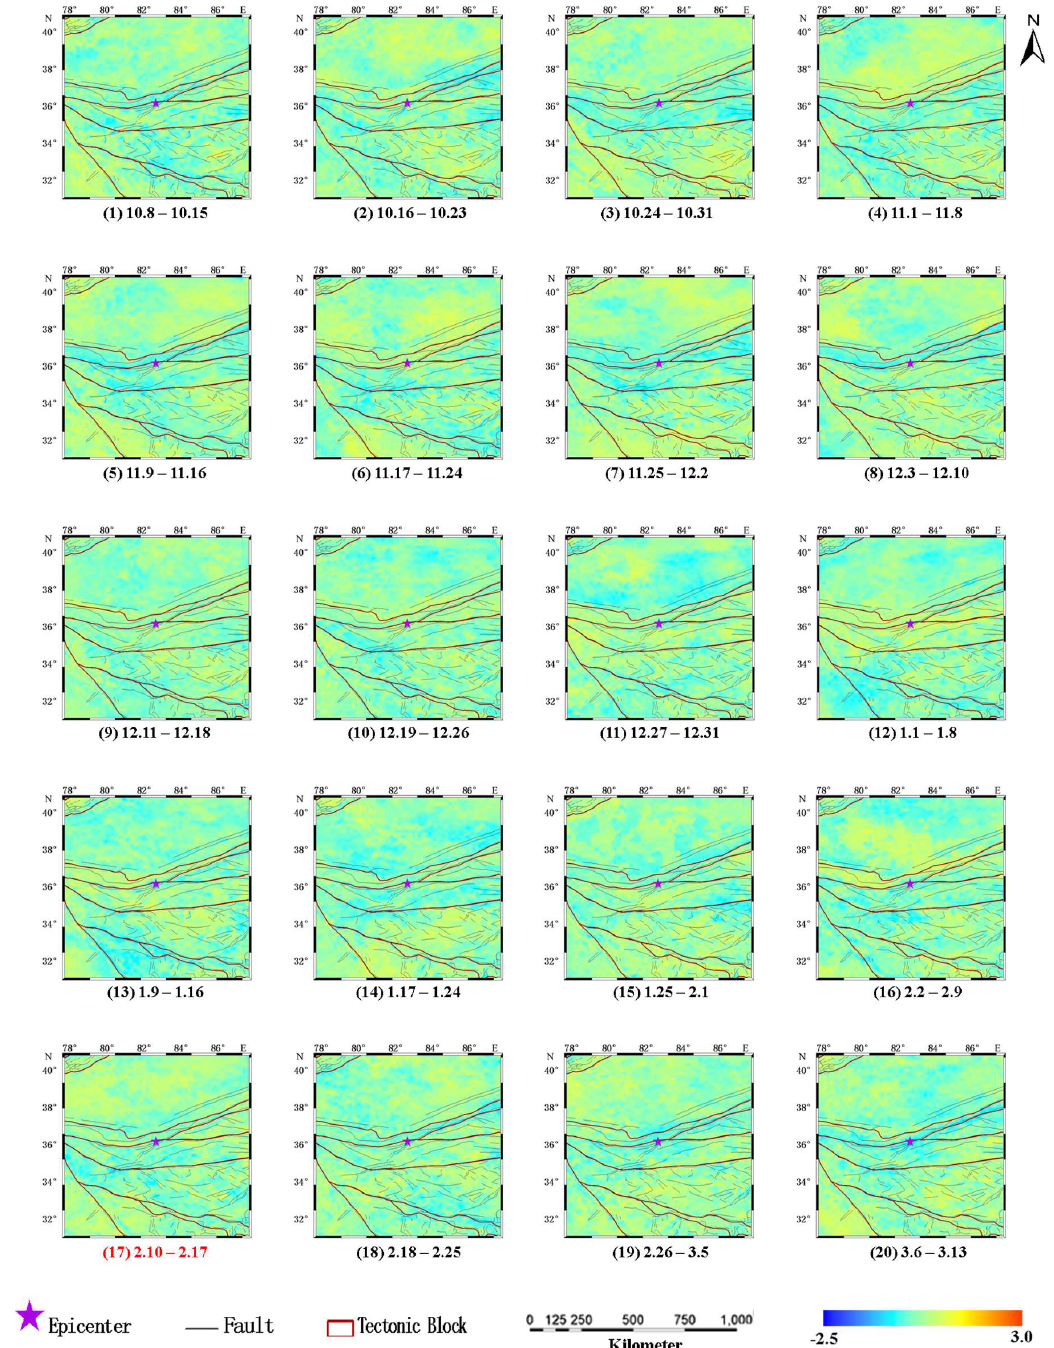
Figure 16. Spatio-temporal evolution of K tec based on the TTIA method in the Altyn-Haiyuan fault region in unperturbed periods. The pixel values in images are the mean values of K tec in the same time-slot of unperturbed periods.